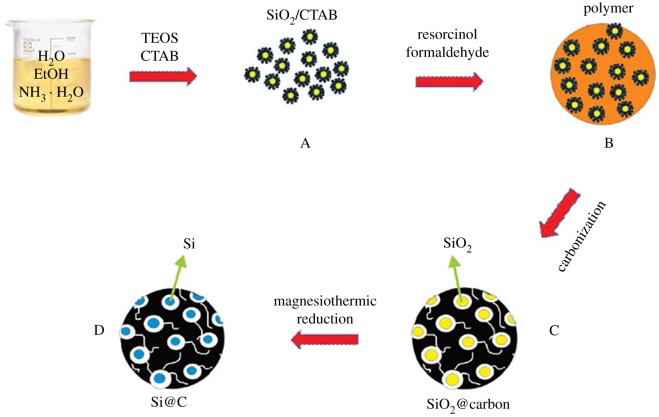
The schematic fabrication of mesoporous Si@C microspheres [16].